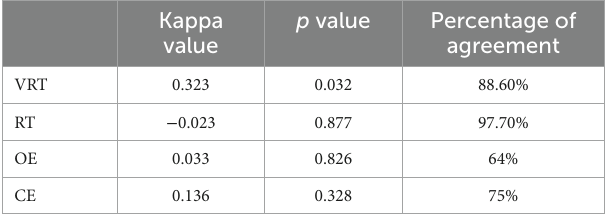
TABLE 5 Percentage of clinical agreement between modalities (online vs. face-to-face) for the Brazilian participants, with the Kappa agreement